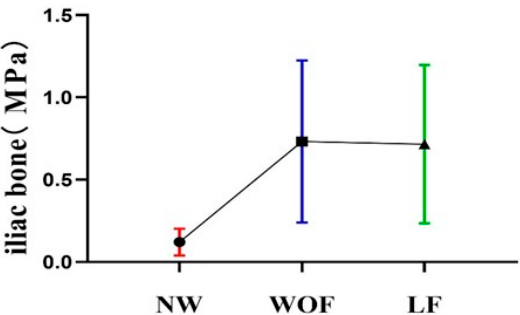
Figure 6. Mean values of stress distribution on the iliac bone during two progressive motions of Bafa Wubu and NW (NW in red; WOF in blue; LF in green).